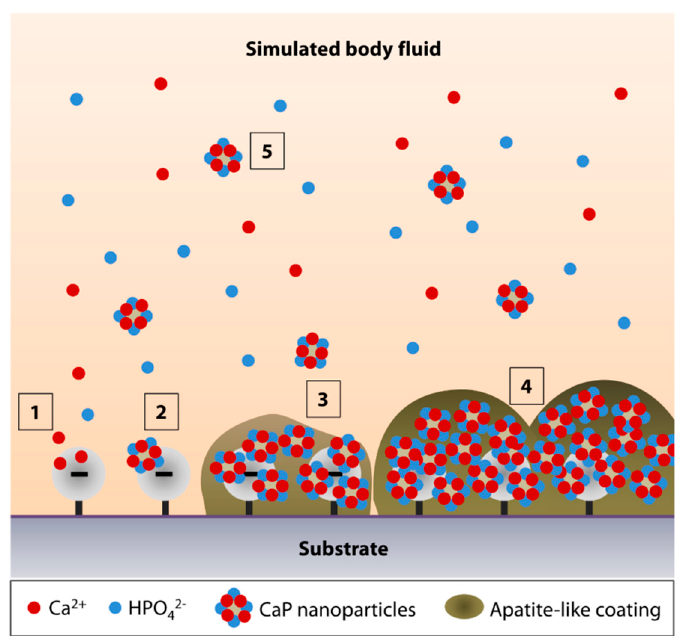
Figure 1. Simulated body fluid (SBF)-mediated mineralization on a negatively charged substrate surface. ( 1 ) Ionic interactions of calcium ions (Ca 2+ ) with a negatively charged surface initiate the apatite nucleation. ( 2 ) Accumulation of Ca 2+ attracts the hydrogen phosphate (HPO 42 − ) ions. ( 3 , 4 ) The accumulation forms CaP nanoparticles or crystals, serving as a secondary nucleation site for continued apatite growth. ( 5 ) The surface nucleation site may also attract the CaP crystals that undergo homogenous nucleation in the SBF.